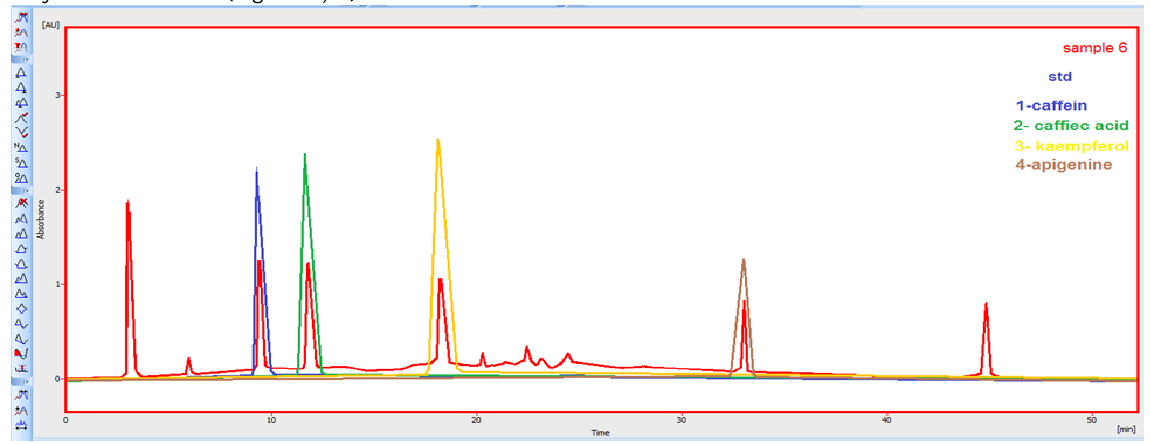
Figure 2. HPLC chromatogram of ethyl acetate fraction.